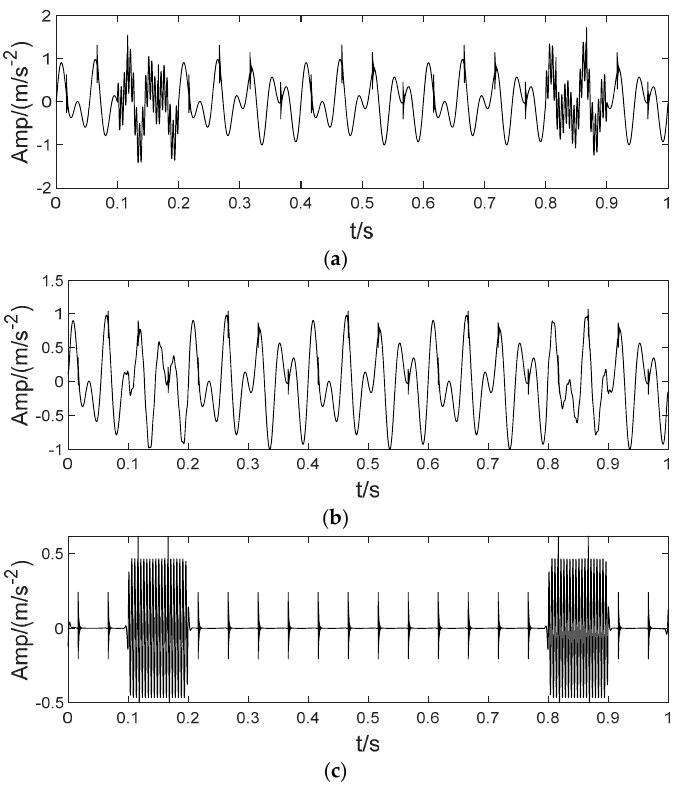
Figure 4. The first decomposition of empirical VMD based on binary tree. ( a ) Original simulation signal. ( b ) denotes the IMF1 component obtained by the first decomposition and ( c ) denotes IMF2.